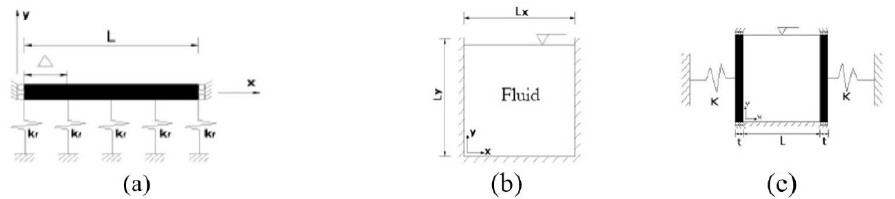
Figure 2. (a) Schematic of the structure (piston) on an elastic base, (b) Short rigid cavity with open upper end. (c) 2D double piston-cavity model with open